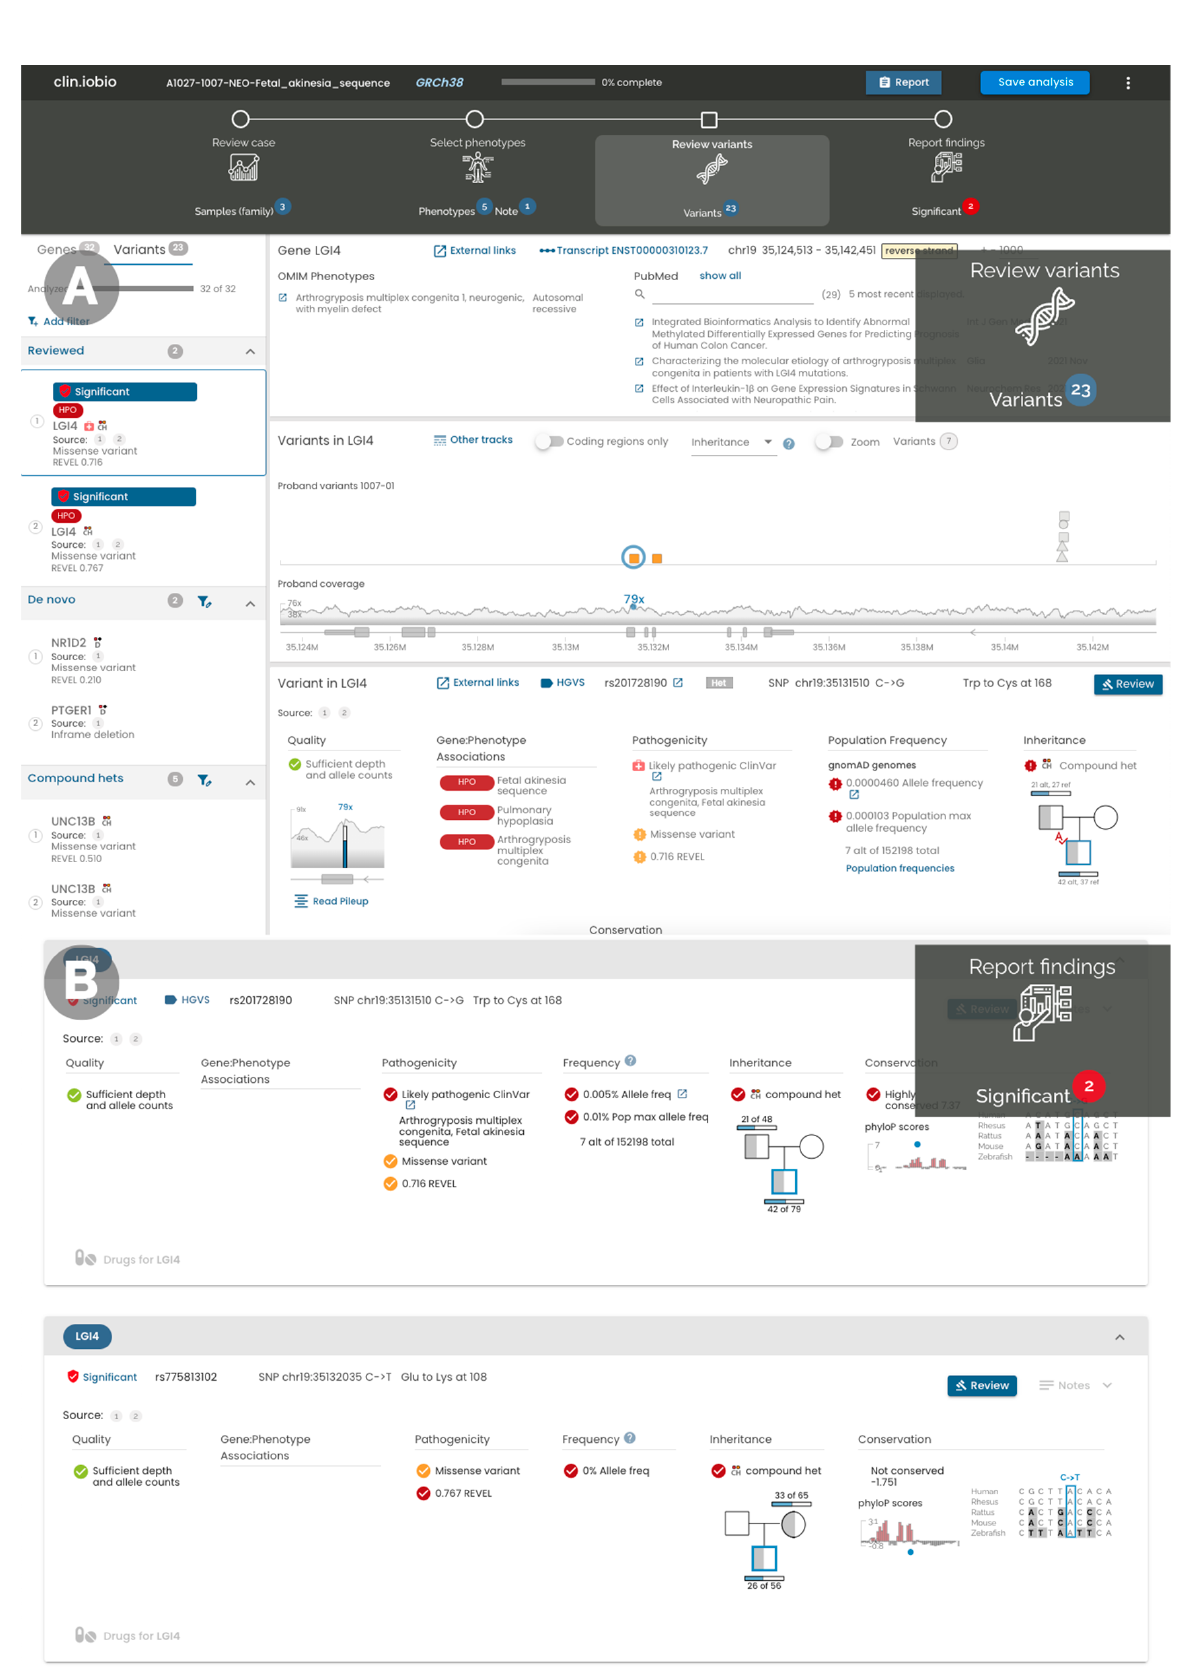
Figure 2. The final two steps in the clin.iobio web app, with the workflow shown at the top of the figure. ( A ) The variant review process includes all candidate variants in the left panel (variants that conform to a set of predefined filters). All variants in the selected LGI4 gene are shown in the middle